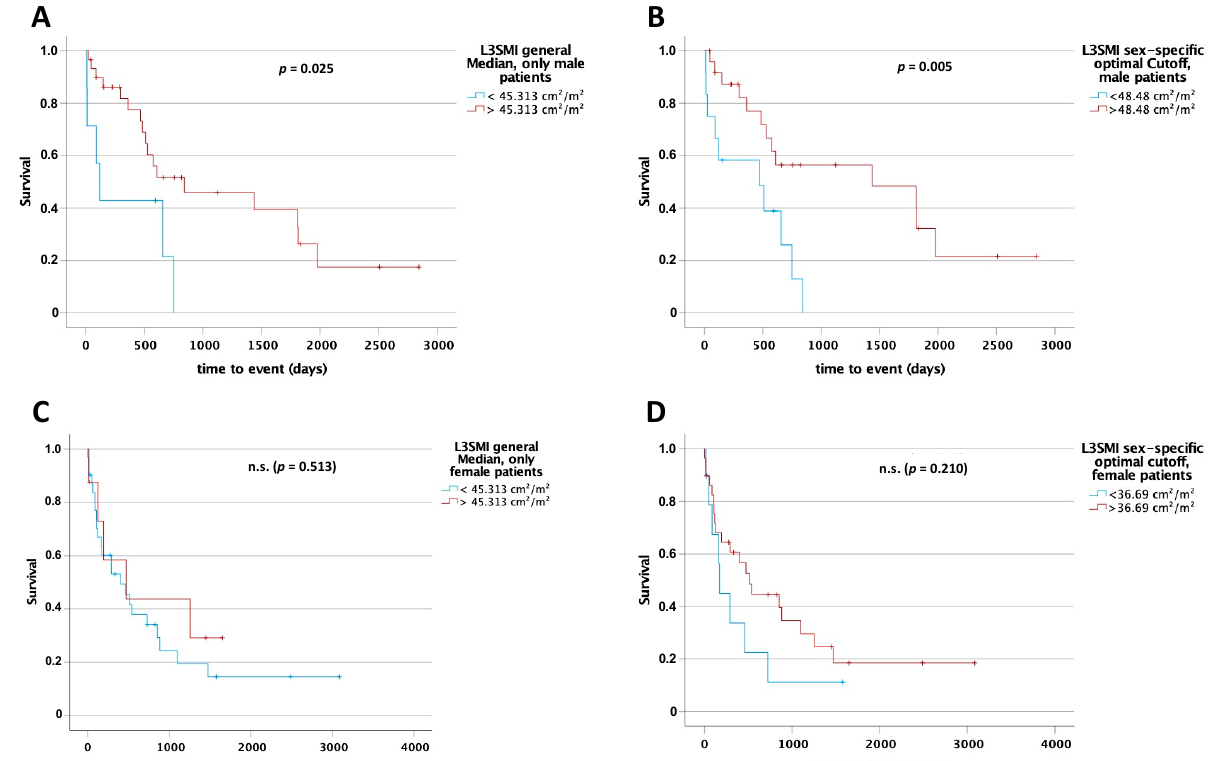
Figure 5. L3SMI is a sex-specific preoperative predictor for overall survival in patients undergoing surgery for CCA. Using the median (45.313 cm 2 /m 2 ) for L3SMI of the total study cohort as a cut-off for overall survival in male ( A ) and female ( C ) subgroups, only in male patients could a significant difference in overall survival be identified. After using sex-specific cut-off values differences were seen in male patients (48.48 cm 2 /m 2 ) only ( B , D ). n.s. = not